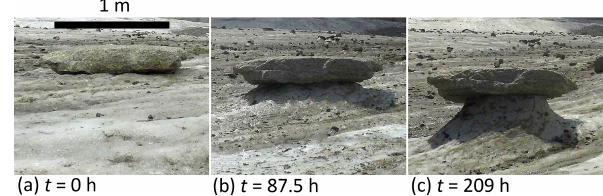
Figure 1. (a–c) Formation of a natural granite glacier table (rock 1; see Table 1).